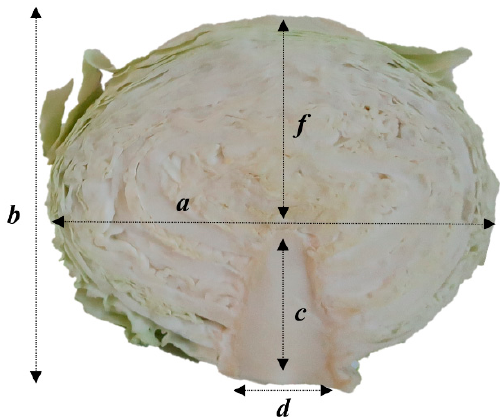
Figure 2. Morphological determination marks. Head width ( a ), head height ( b ), stem base length ( c ), thickness of steam base, ( d ) and distance from the top of stem base to the top of the head ( f ).